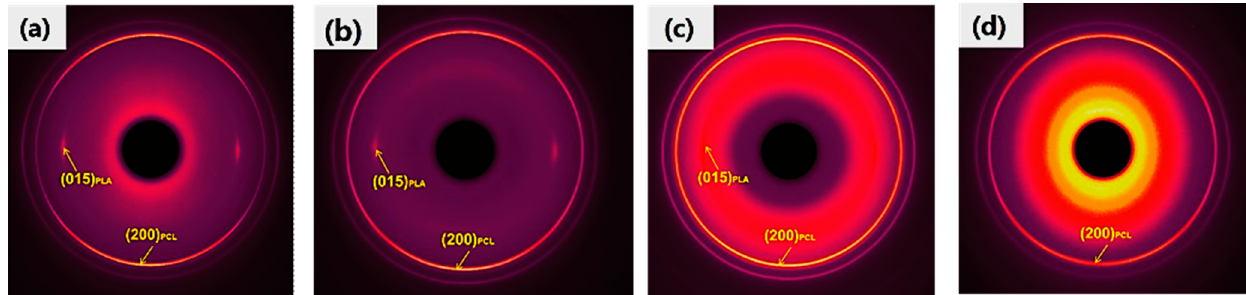
Figure 6. 2D-WAXD patterns of the 80/20 micropart of ( a ) µ -PLA/PCL-15, ( b ) µ -PLA/PCL-20, and ( c ) µ -PLA/PCL-26, and ( d ) the shear layer of 80/20 macropart C-PLA/PCL. The flow direction is vertical.